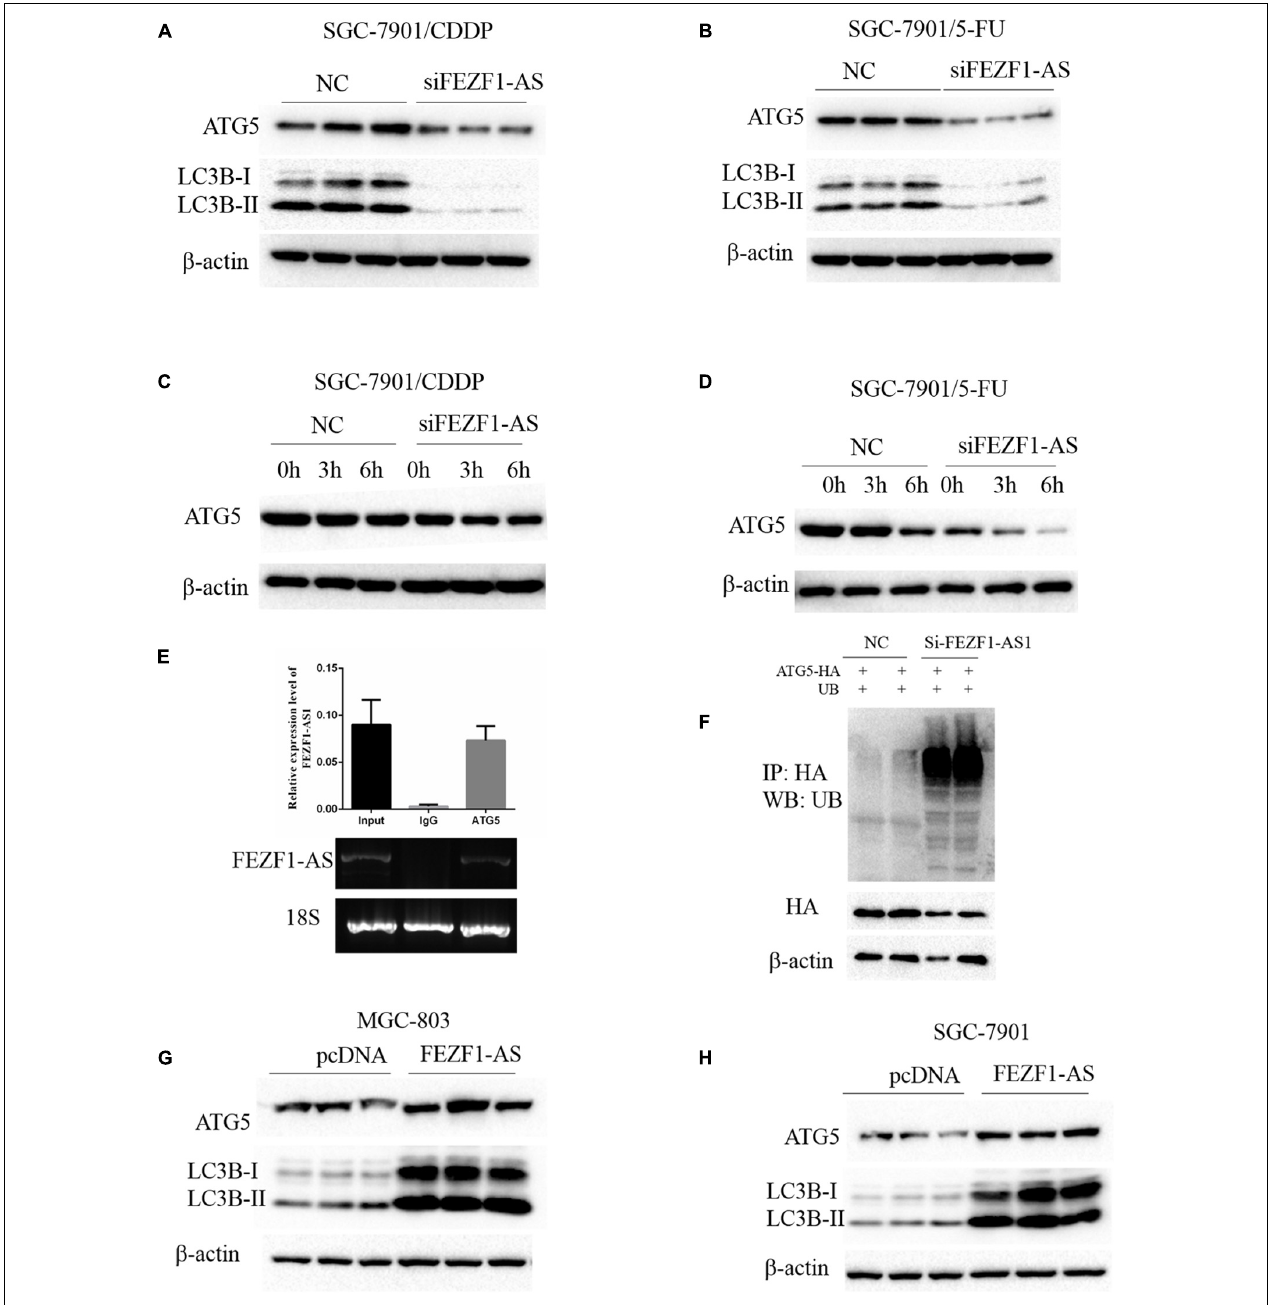
FIGURE 4 | FEZF1-AS1 regulated chemo-resistance of GC cells through modulating autophagy. Western blot analysis of LC3 and ATG5 protein levels in SGC-7901/CDDP cells (A) and SGC-7901/5-FU cells (B) treatment with FEZF1-AS1 siRNA or NC. The protein stability of ATG5 in SGC-7901/CDDP cells (C) and SGC-7901/5-FU cells (D) analyzed by Western blot in cells treated with cycloheximide (50 µ g/ml) at different time points. (E) RIP assays using an anti-ATG5 antibody showed that ATG5 interacts with FEZF1-AS1 in SGC-7901 cells. The qRT-PCR results of RIP assays are shown in the top. The results of agarose electrophoresis of the PCR products are shown in the bottom. (F) Knockdown the expression of FEZF1-AS1 increased the ubiquitous modification of ATG5. Western blot analysis of LC3 and ATG5 protein levels in MGC-803 (G) cells and SGC-7901 (H) cells transfected with FEZF1-AS1 overexpression plasmids or its vector plasmids. Each experiment was performed in